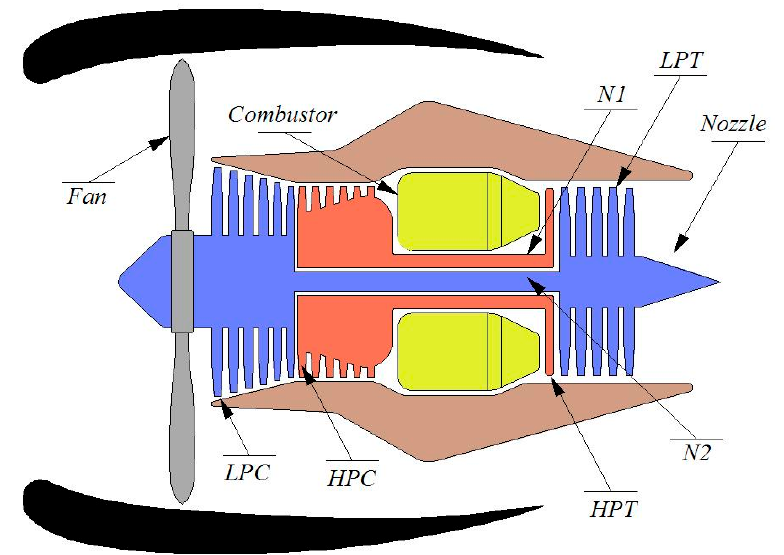
Figure 1. Simplified diagram of the engine simulated (LPC: low pressure compressor; HPC: high pressure compressor; N1: turbine shaft; N2: turbine axis; LPT: low pressure turbine; and HPT: high pressure turbine).